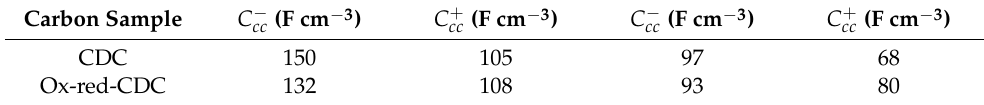
Table 2. Specific capacitance of CDC and ox-red-CDC by CC at negative and positive potential. Carbon